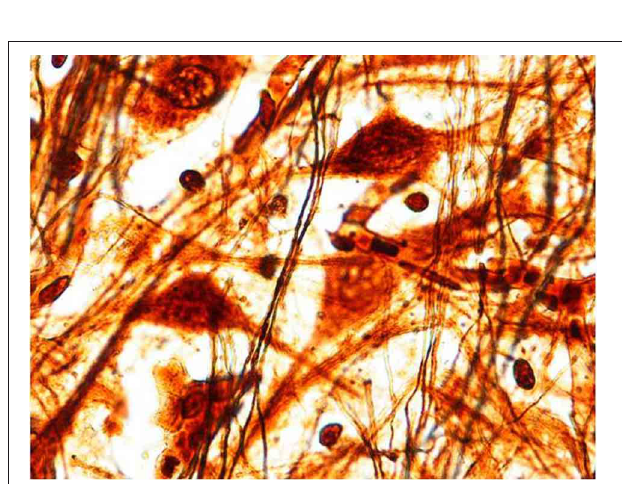
FIGURE 4 | Multipolar/stellate neurons with broad dendritic arbors in the MSO (2 month-old control). Bielchowsky’s silver impregnation stain. Magnification: 100 ×